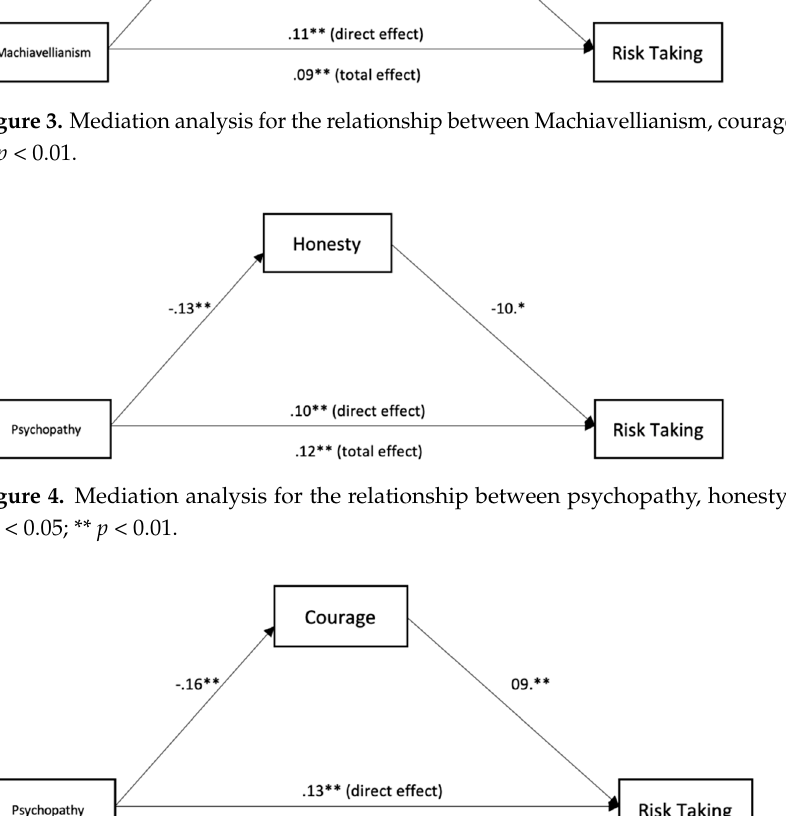
Figure 5. Mediation analysis for the relationship between psychopathy, courage, and risk-taking. ** p < 0.01